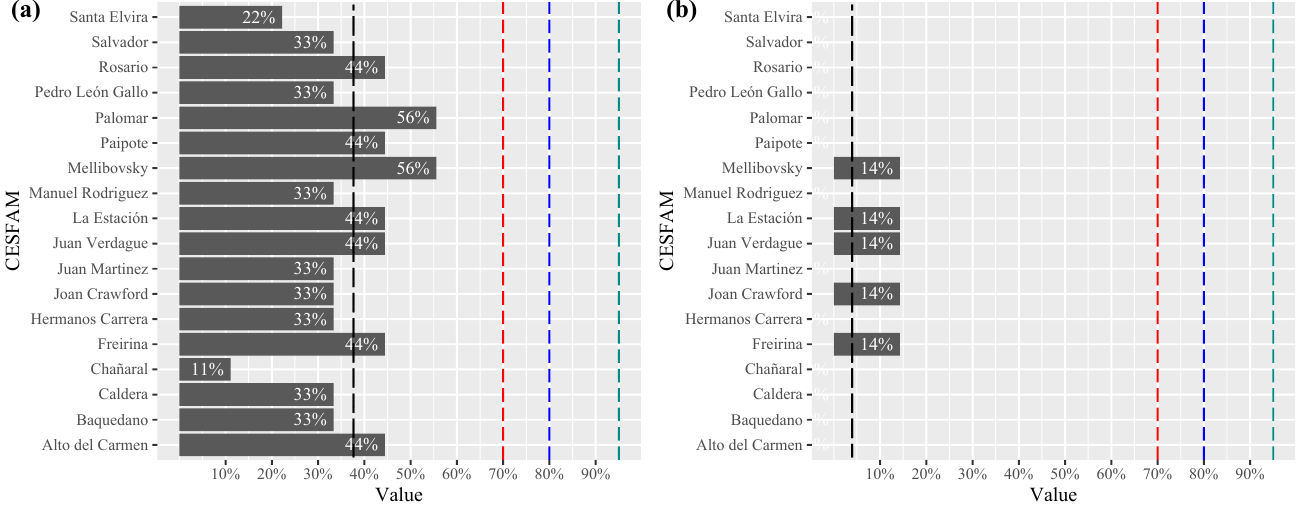
Figure 4. Level of compliance with the ( a ) participation dimension, ( b ) information dimension. (Family Healthcare Center (CESFAM), mean dash – – black, lim 70% dash – – red, 80% dash – – blue and 95% dash – –